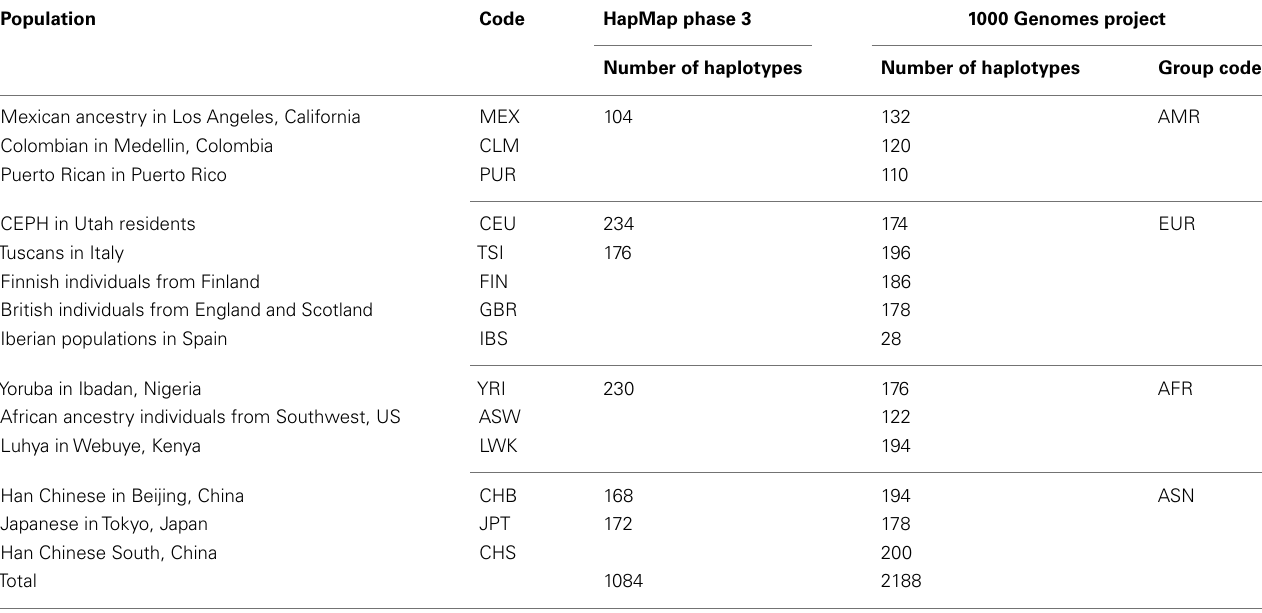
Table 1 | Phased haplotypes downloaded from the MACH